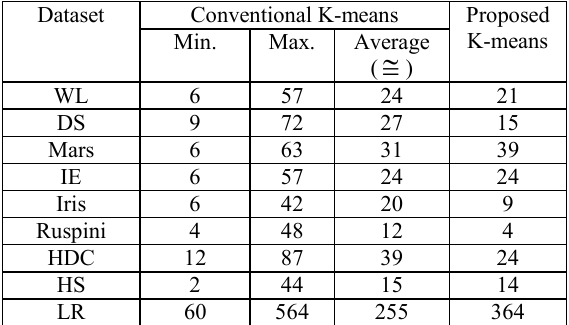
Table 3. Step number of algorithms for all